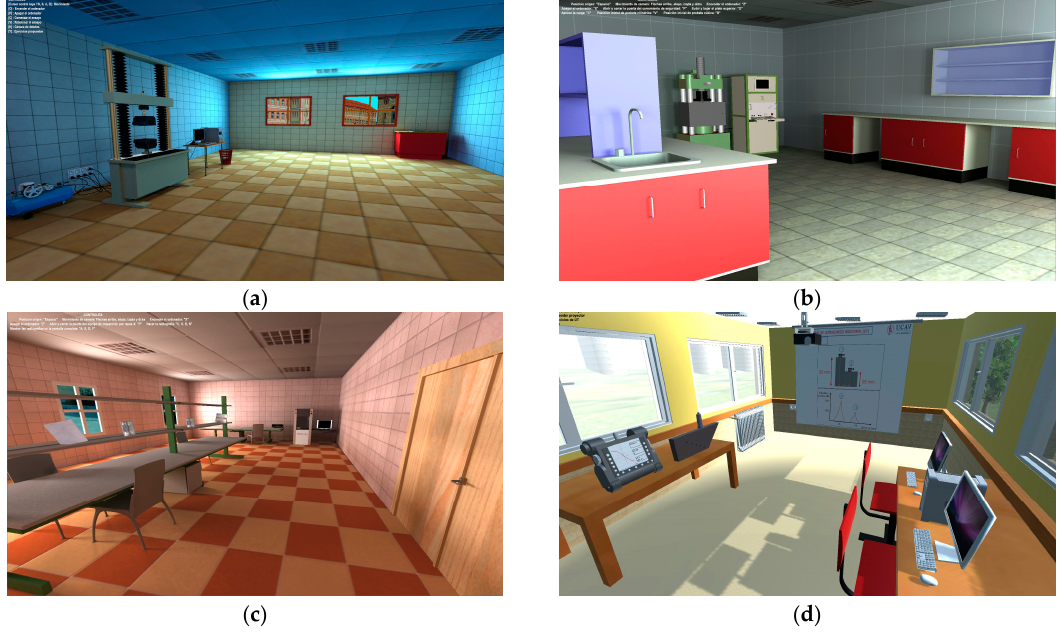
Figure 5. VR applications related to testing materials: ( a ) tensile testing [9]; ( b ) compression testing [10,12]; ( c ) X-ray testing [15]; ( d ) ultrasonic testing.